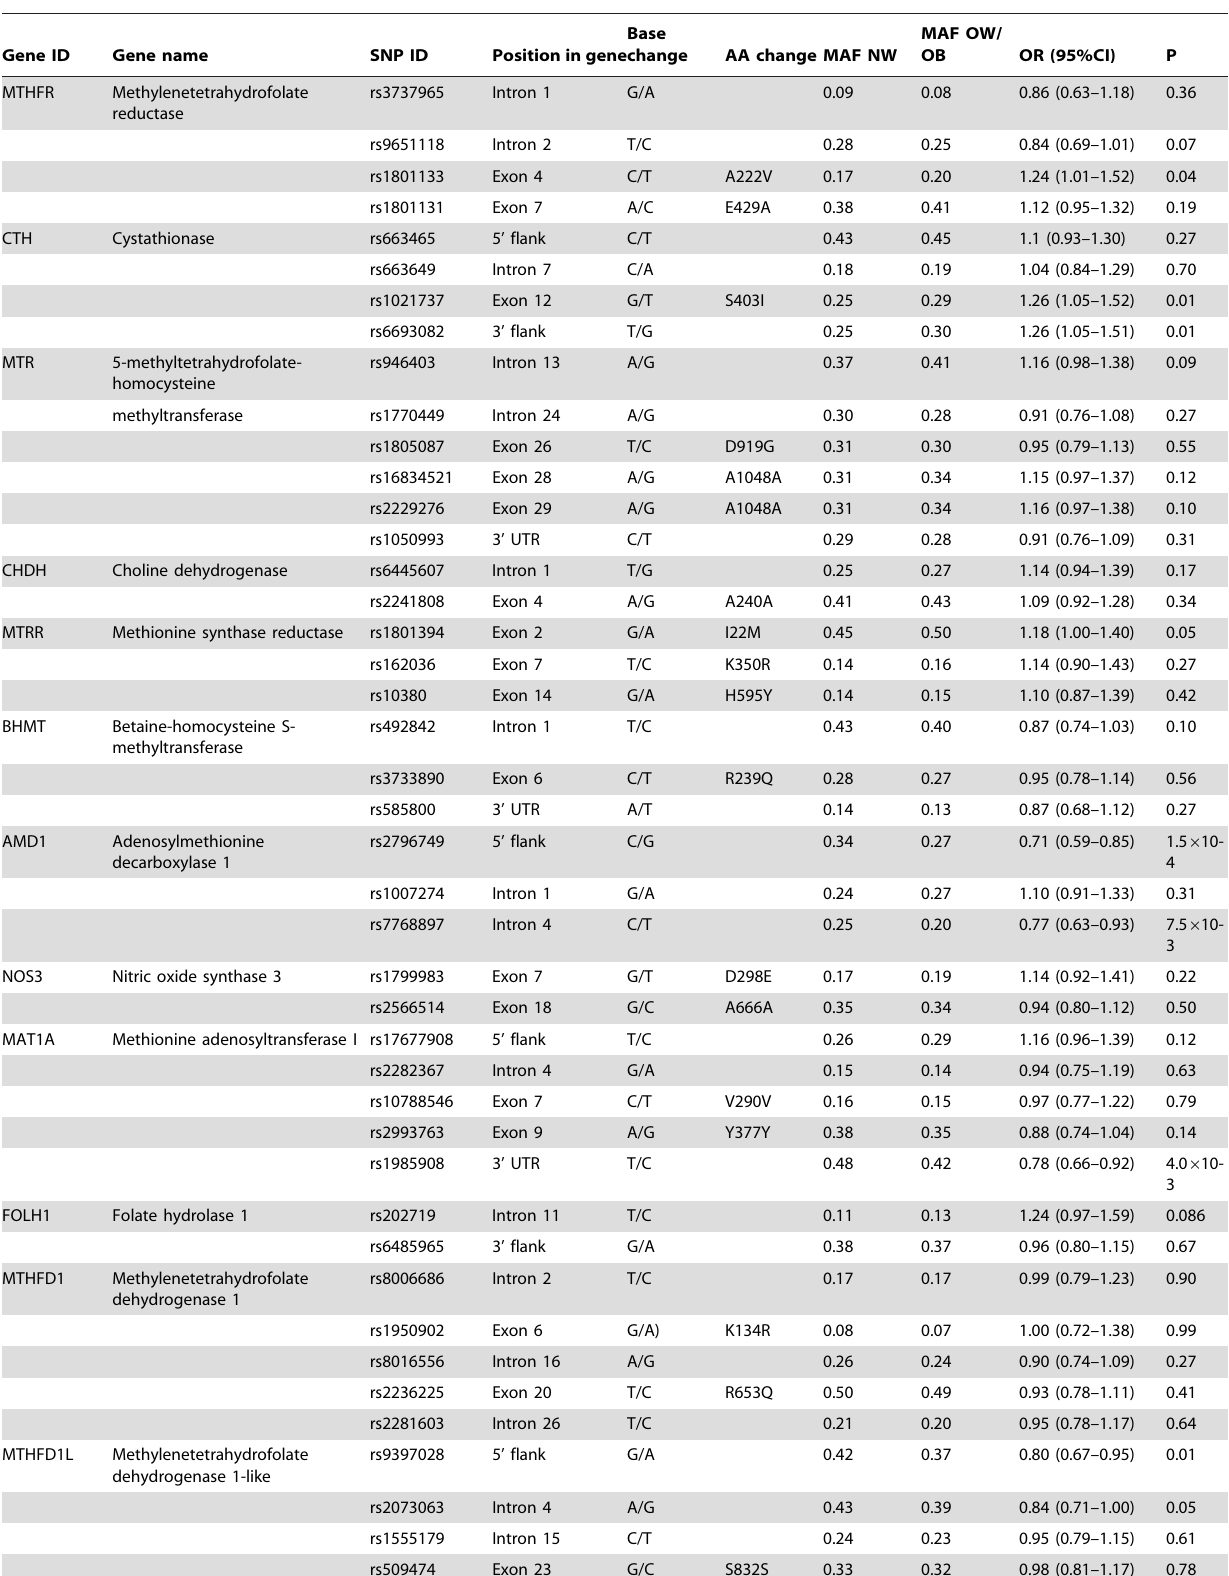
Table 2. Homocysteine metabolism pathway genes and association analysis of their variants with obesity in Indian